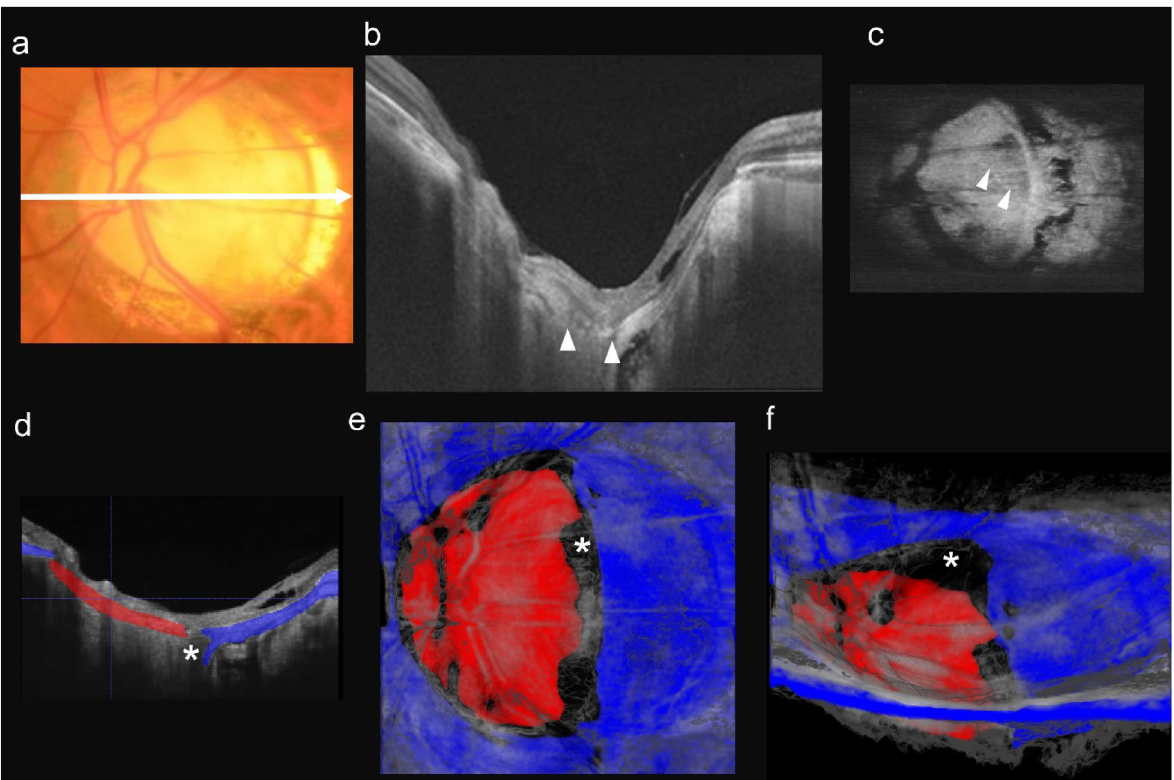
Figure 4. Color fundus photograph and OCT images of a 55-year-old highly myopic man with a lamina cribrosa defect (LCD). ( a ) Color fundus photograph showing the optic disc of the left eye. Myopic conus is present in the peripapillary area especially at the temporal part to the optic disc. White arrow shows scanning line for OCT images. ( b ) Horizontal OCT cross-sectional image showing the LCD. White arrowheads show the edges of the LCD. ( c ) En face OCT image of the optic disc at the level of the lamina cribrosa (LC) showing that the whole structure of the LCD is not clearly imaged due to a tilting of the optic disc. The LCD is pointed to by the white arrowheads and is seen as hyporeflective spots with unclear boundary. ( d ) Height adjusted OCT image as (b) with manual labels showing the PPS (blue) and lamina cribrosa (red). ( e,f ) 3D images generated with the trained deep convolutional neural network. ( e ) En face 3D image with asterisk indicating the defect showing that the LCD runs vertically at the temporal edge of the disc. f: 3D image viewed from the inferior side of the fundus with asterisk pointing to the LCD showing that the LCD appears to be torn apart from the edge of the